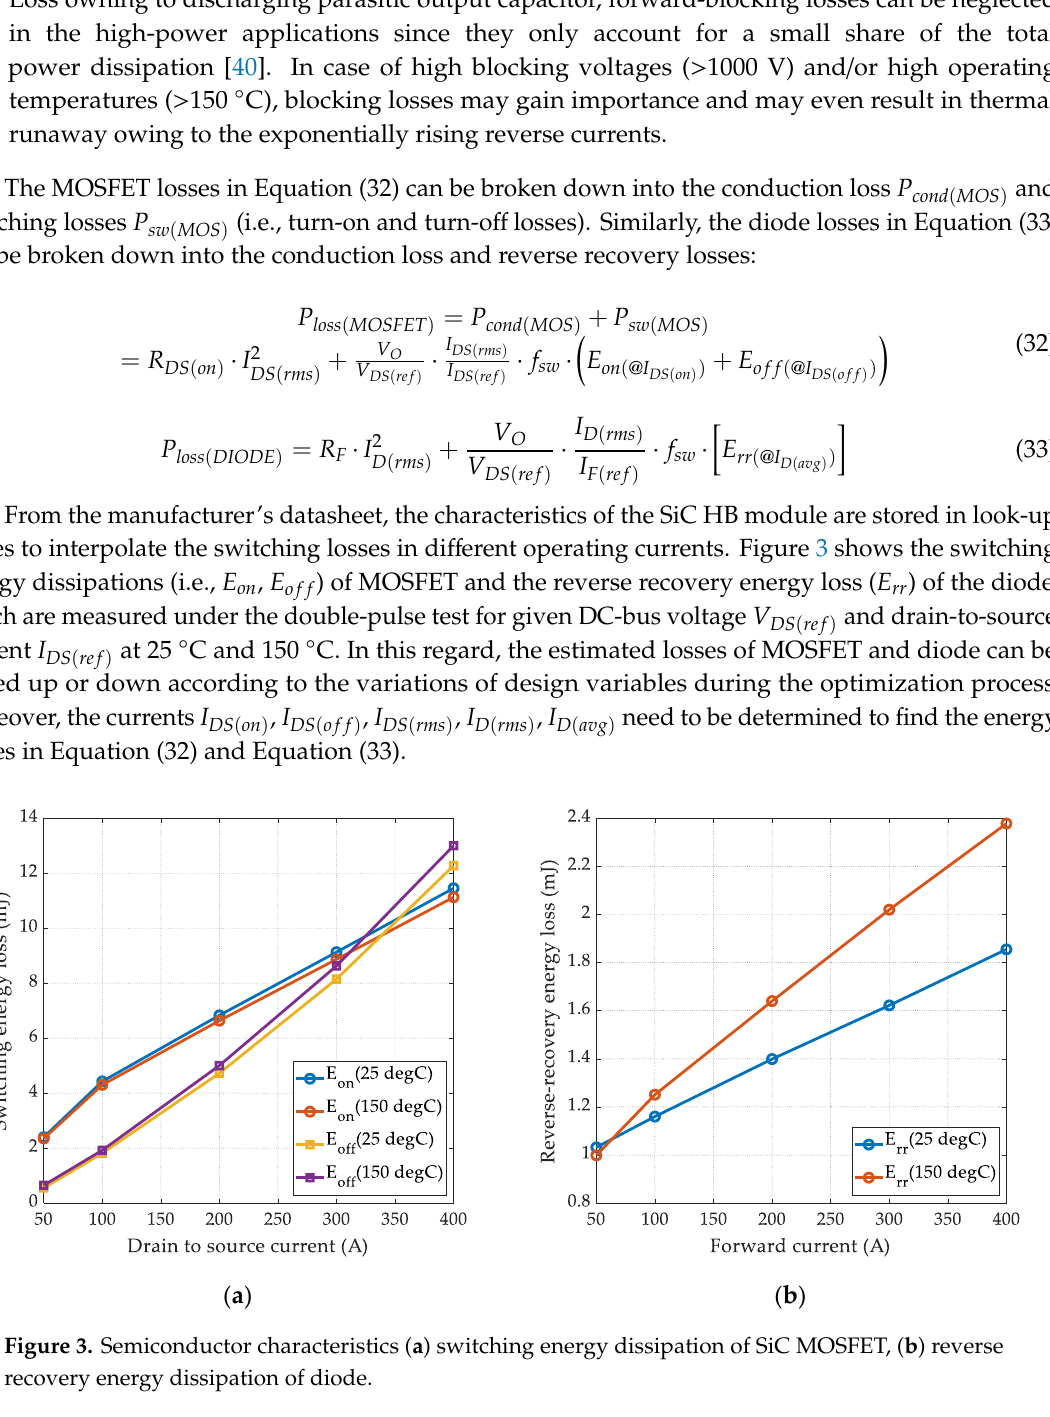
Table 5. Current calculation for MOSFET (lower side) and diode (upper side) in boost operation with an average inductor current